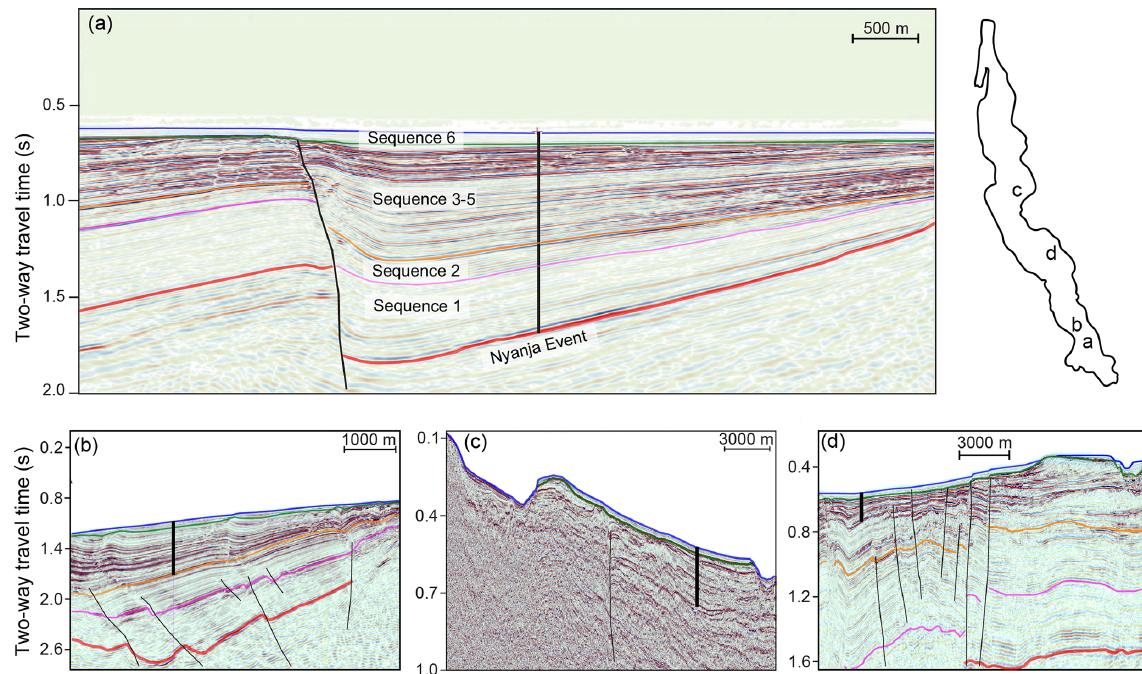
Figure 3. Seismic reflection profiles showing potential drilling sites at Lake Tanganyika. Panel (a) illustrates a potential drilling site that captures the major seismic sequences (S1–S6) present in the lake. Sequences S3–S5 are condensed and likely truncated by erosion at this site, but these sequences can be drilled at a nearby site in deeper water (b) . Panels (c) and (d) illustrate sections in shallower water where fossiliferous sediments can be drilled for evolutionary biological studies. In all panels, black lines indicate potential drill holes, blue lines trace the lake floor; red lines indicate the Nyanja event (the interpreted base of the modern rift); and pink, orange, and green lines trace the boundaries between sequences 1 and 2, 2 and 3, and 5 and 6,